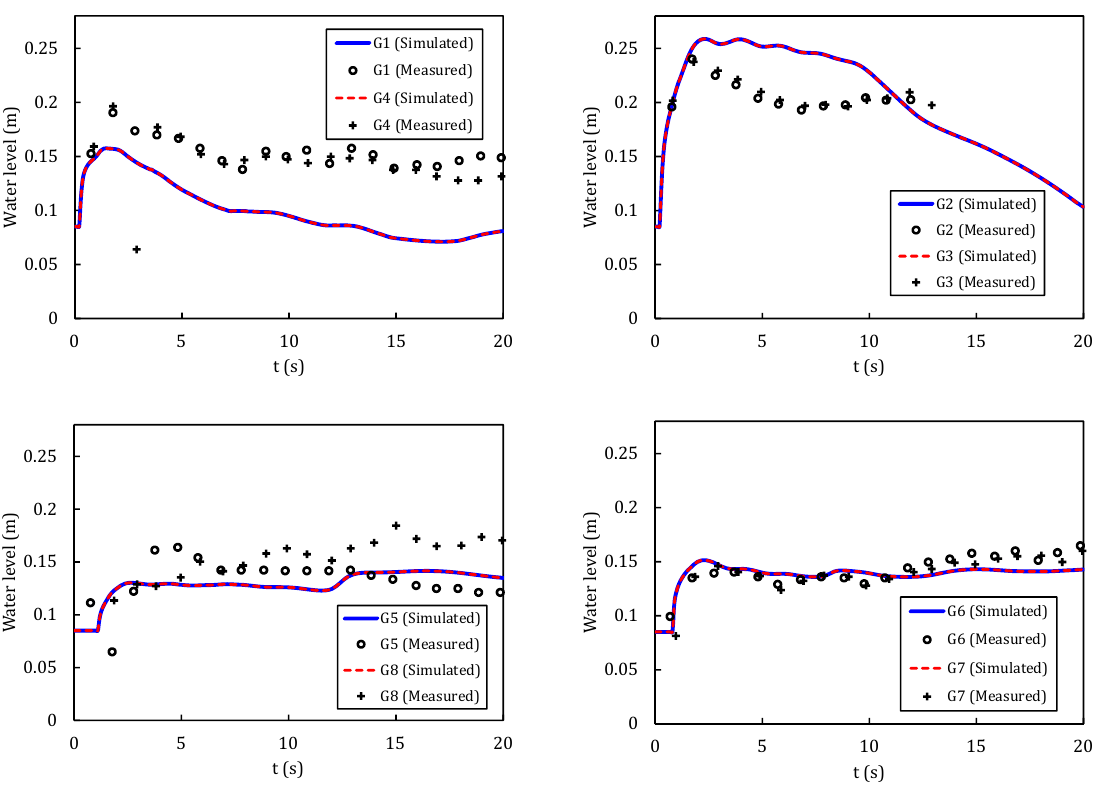
Figure 17. The measured and calculated water level at four pairs of ultrasonic gauges